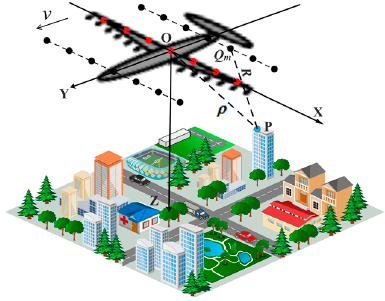
Figure 1. Imaging geometry of DLSLA 3-D SAR.